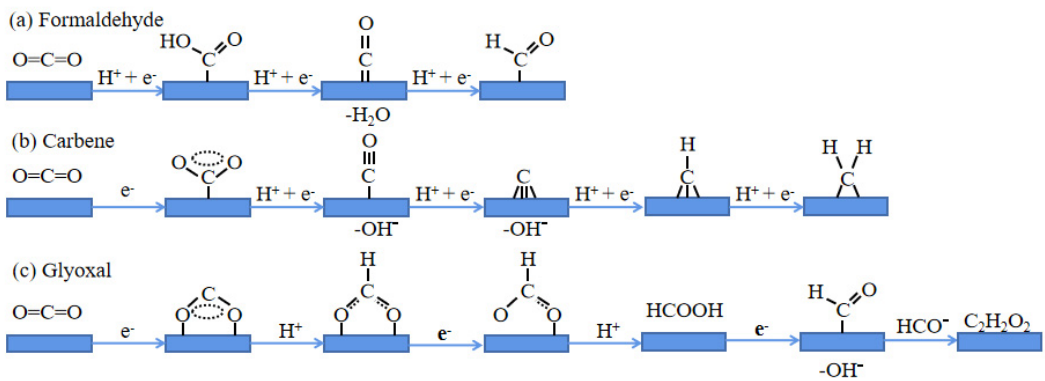
Figure 2. Different ways of reducing carbon dioxide: ( a ) formaldehyde; ( b ) carbene; ( c ) glyoxal [42,54–56].